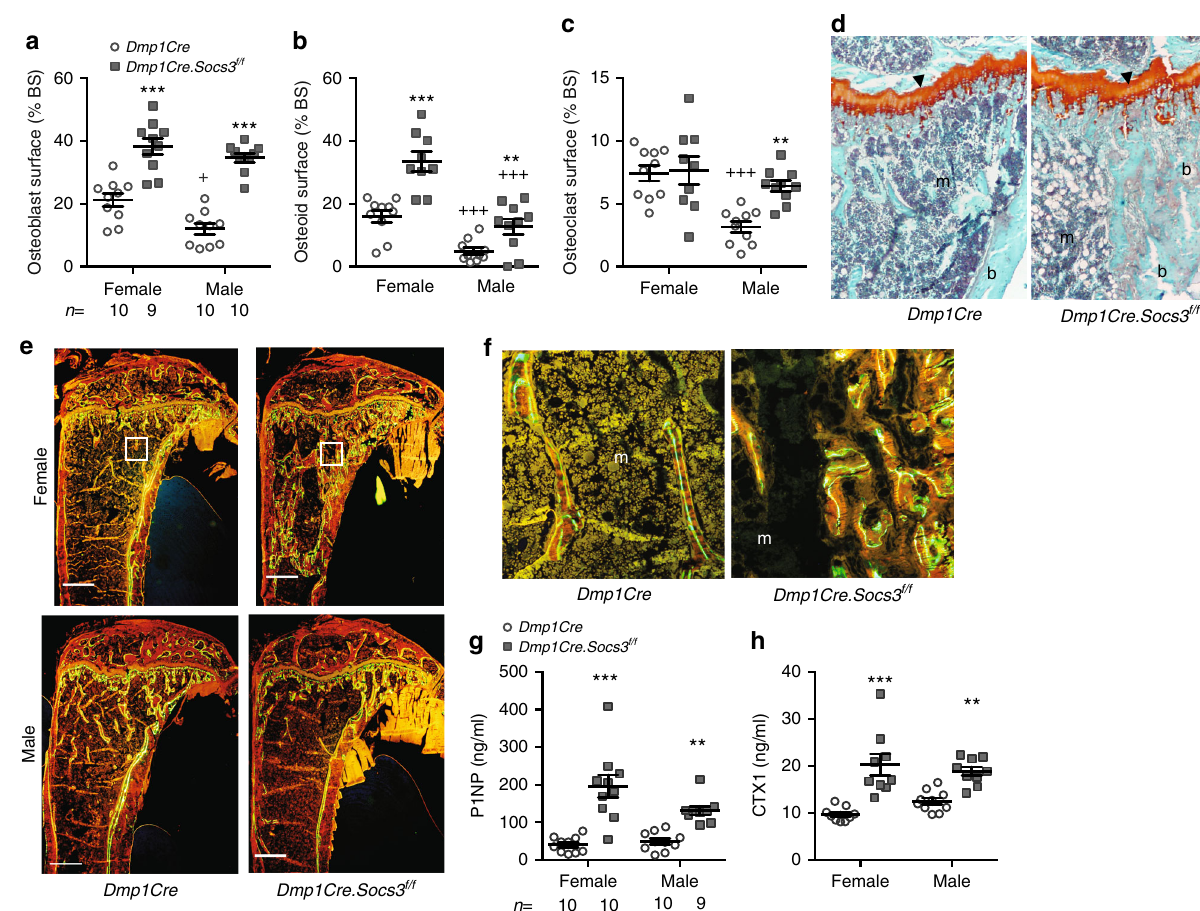
Fig. 3 Sex divergence of the Dmp1Cre.Socs3 f/f phenotype explained by a male-speci fi c effect on osteoclast numbers at 12 weeks of age. a – c Histomorphometric analysis of osteoblast surface ( a ), osteoid surface ( b ), and osteoclast surface ( c ) in the secondary spongiosa of 12-week-old male and female Dmp1Cre ( open circles ) and Dmp1Cre.Socs3 f/f ( gray squares ) tibiae; values are mean ± SEM, n is shown for each group below ( a ). ** p < 0.01; *** p < 0.001 vs Dmp1Cre of the same sex; + p < 0.05, +++ p < 0.001 vs female of the same genotype by two-way ANOVA with Sidak post-hoc test. d Safranin O staining shows no retention of cartilage remnants (orange) within the trabecular bone (b) of female Dmp1Cre.Socs3 f/f mice compared with Dmp1Cre mice; m marrow; scale bar = 50 µ m. e Representative images of calcein labeling of bone in male and female 12-week-old Dmp1Cre.Socs3 f/f and Dmp1Cre mice. Scale bar = 500 µ m. f High-power images from the boxed regisons shown in e showing lamellar bone formation in the secondary spongiosa in female Dmp1Cre mice (left), but woven-bone formation in the same region in female Dmp1Cre.Socs3 f/f mice (right); scale bar = 50 µ m. g , h Biochemical markers of bone formation (P1NP) and resorption (CTX-1) in 26-week-old male and female Dmp1Cre.Socs3 f/f ( open circles ) and Dmp1Cre ( gray squares ) mice; values are mean ± SEM, n is shown for each group below ( g ). * p < 0.05; ** p < 0.01; *** p < 0.001; vs Dmp1Cre of the same sex by two-way ANOVA with Sidak